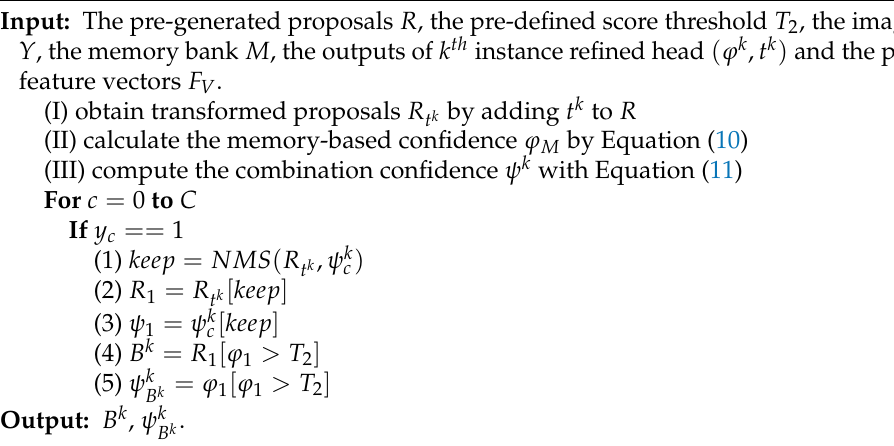
Algorithm 3 Memory-aware instance mining